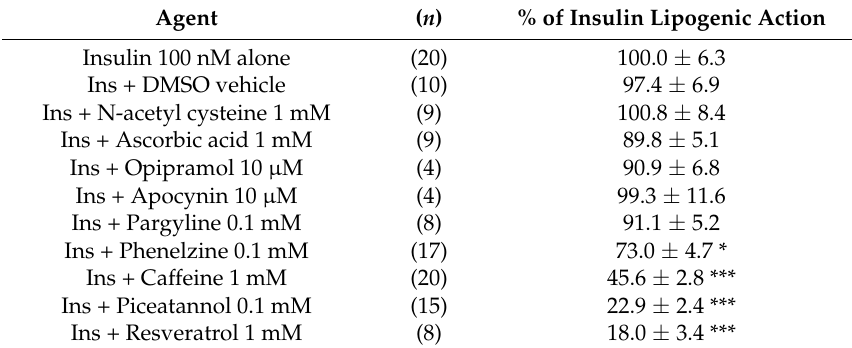
Table 1. In vitro effects of antioxidants, receptor agonists, or enzyme inhibitors on insulin stimulation of glucose incorporation into neosynthesized lipids of mouse